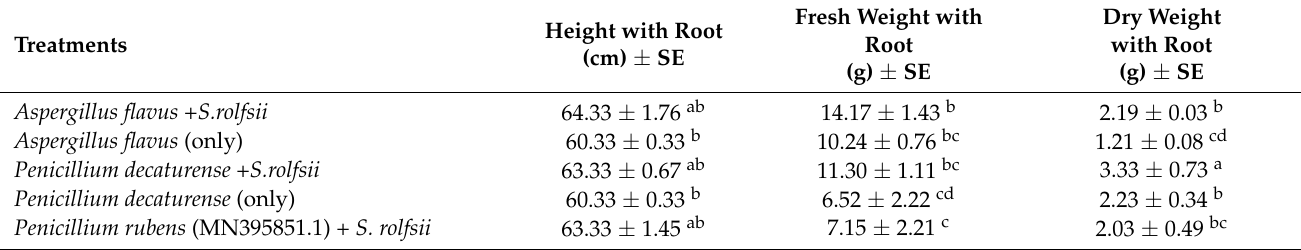
Table 4. Effect of antagonistic fungi on the height, fresh weight, and dry weight of peanut plants infected and non-infected with Sclerotium rolfsii